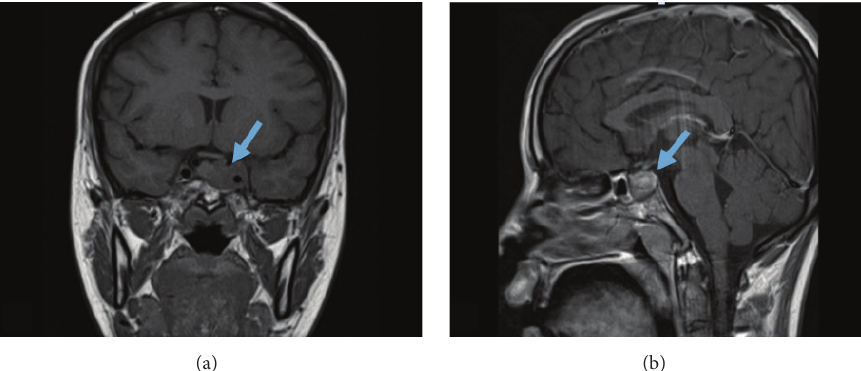
Figure 3: T1 coronal (a) and T1 sagittal (b) sections of the brain on presentation showing a 2.2 × 2.1 × 2.2 cm intrasellar mass in keeping with a pituitary macroadenoma invading the left cavernous sinus and completely encasing the left internal carotid artery.